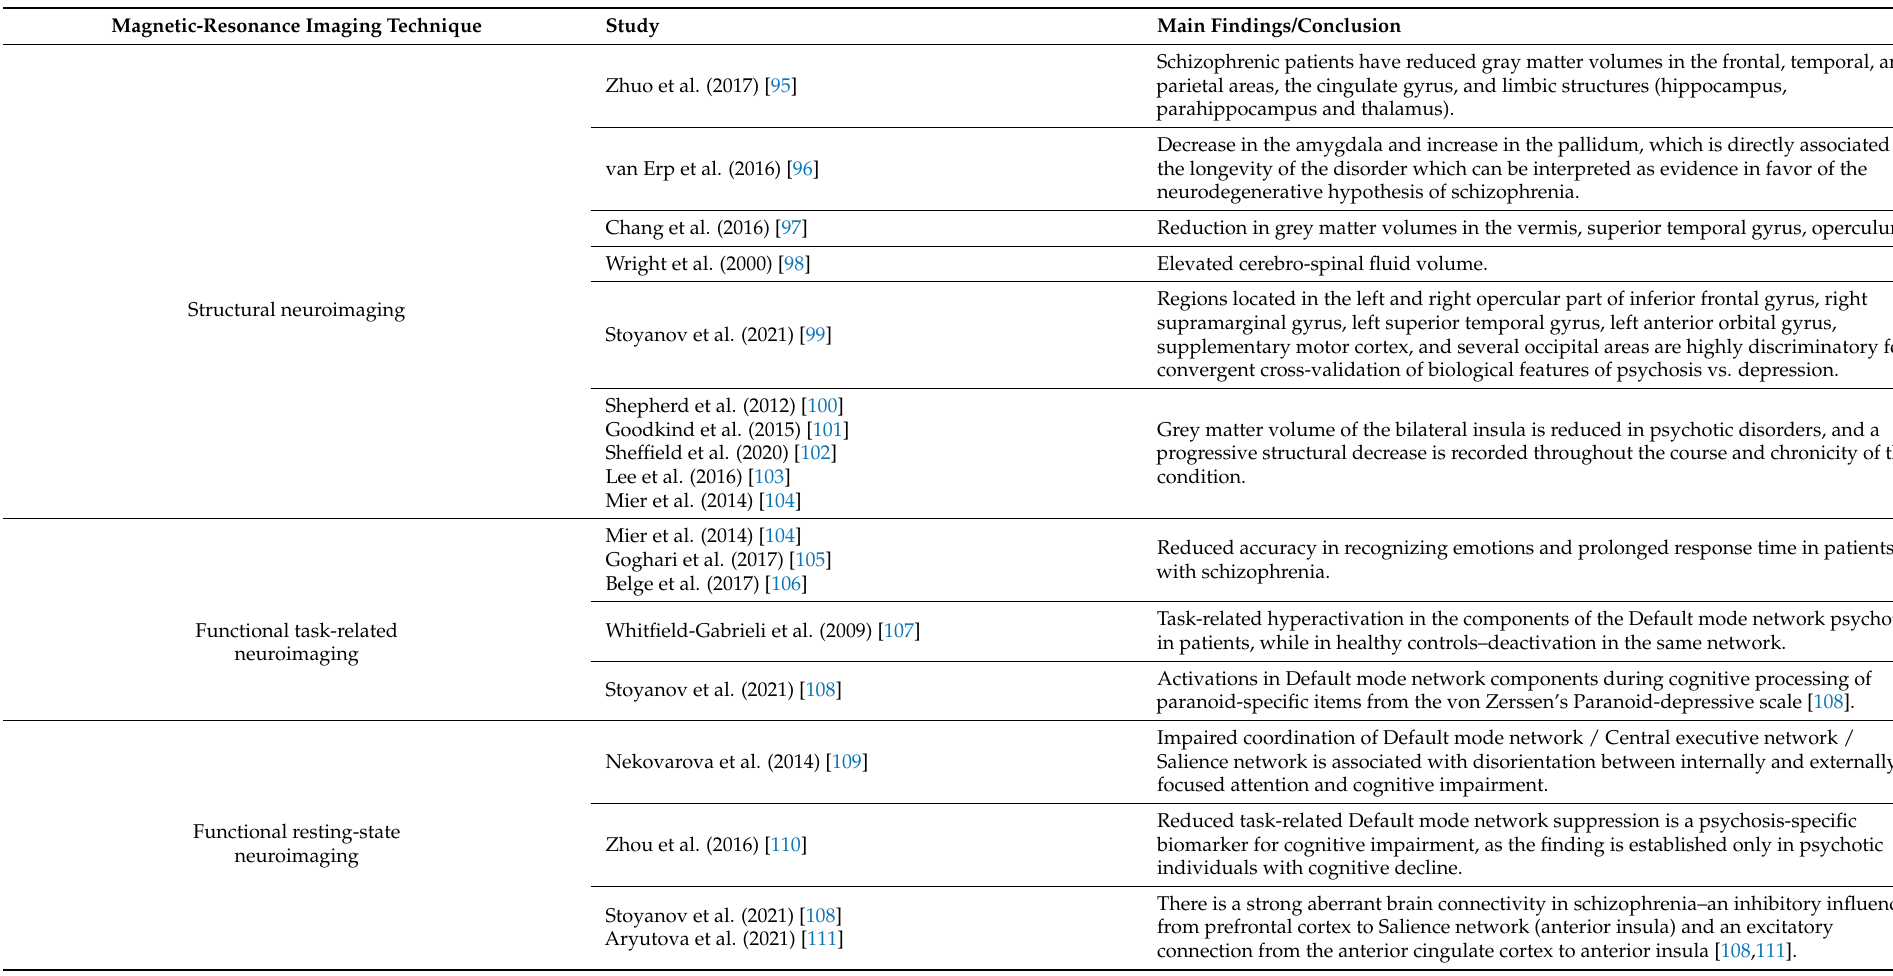
Table 2. Magnetic resonance imaging findings in schizophrenia